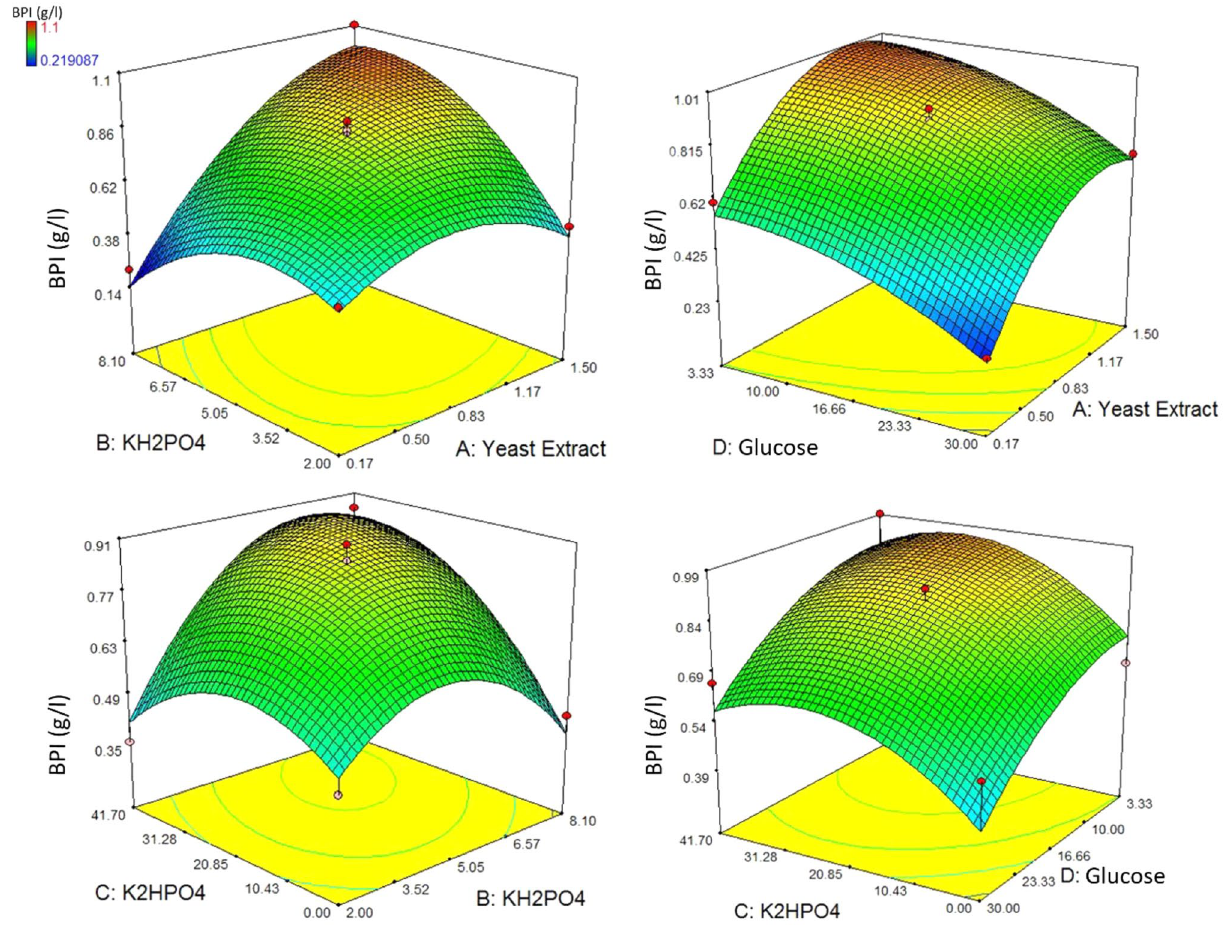
Fig. 5 RSM plot demonstrating effects of optimization variables; in each picture effect of two variables on BPI can be seen at fixed level of two other